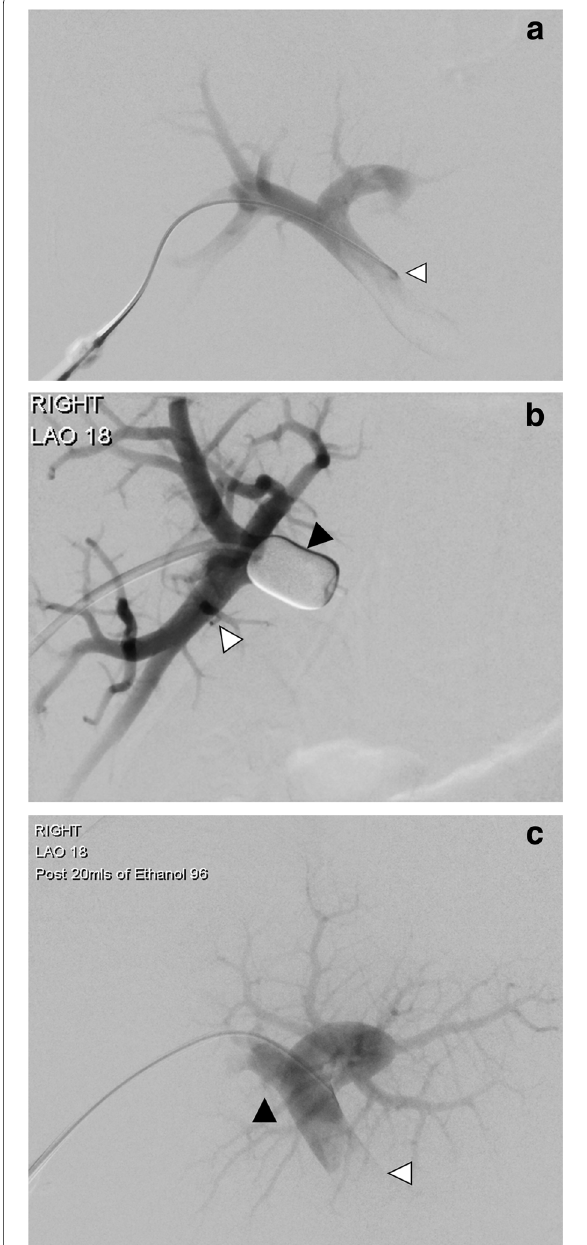
Fig. 2 a Venography of the portal system via a transhepatic approach via catheter in the main portal vein (white arrow), which demonstrates portal anatomy prior to embolization. b Venography of the portal system via the sheath with the LeMaitre balloon inflated (black arrow), demonstrating adequate occlusion of the right portal system (white arrow). c Venography of the portal system, demonstrating patent main portal vein (white arrow) and successful occlusion of the right portal system (black